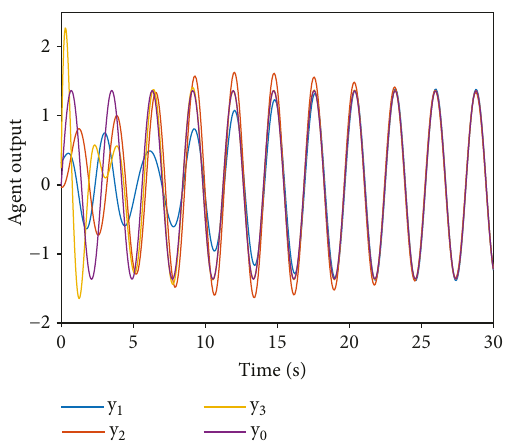
4: The follower output y by i = 1,2,3 and leader output y 0 i output-feedback control (31).